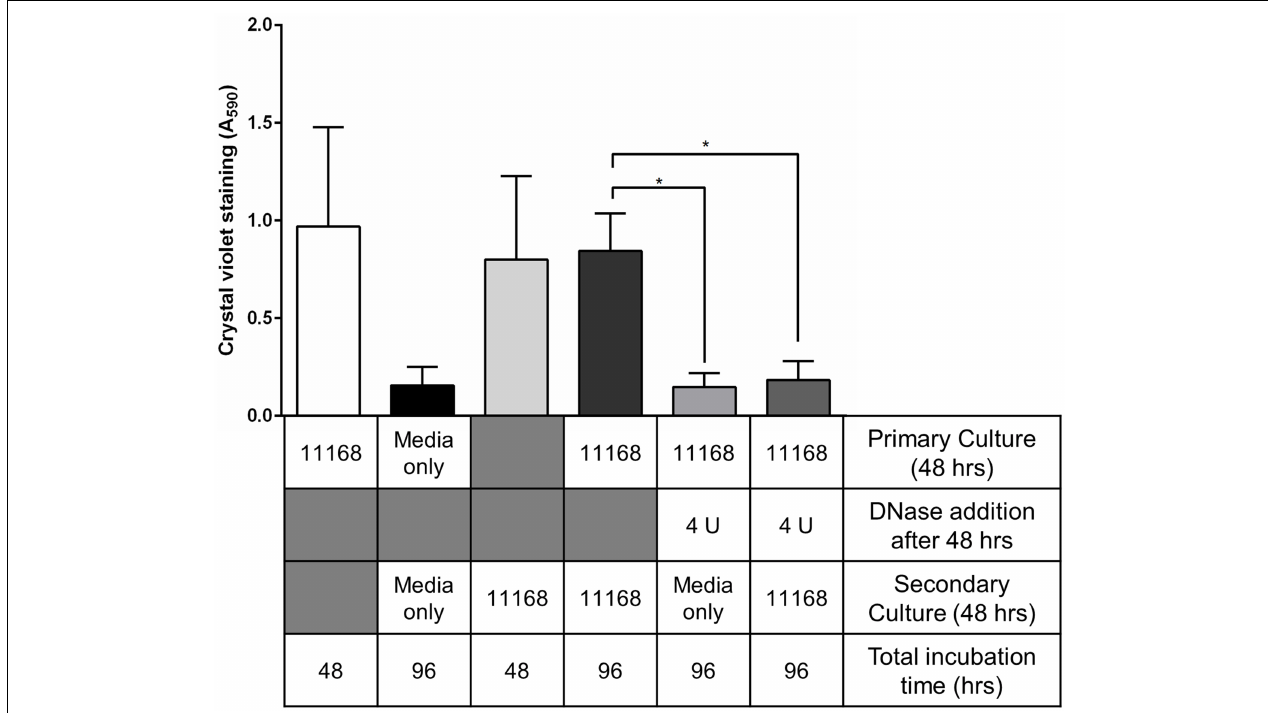
C. jejuni NCTC 11168 biofilm formation following primary culture (first bar, white), tubes supplemented with sterile Brucella media (second